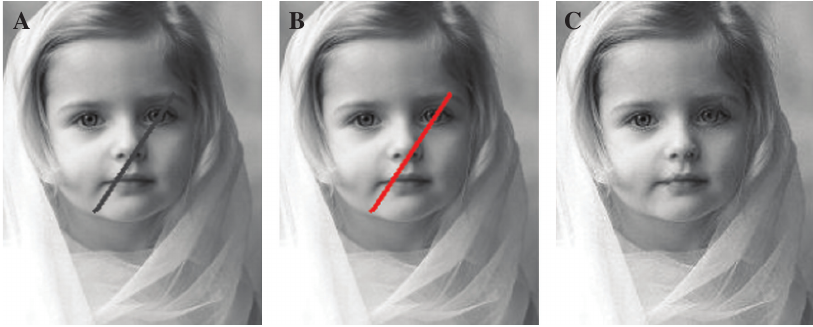
Figure 10. Results with Scratch on Edges (Nice4): Patch Size 7 × 7.